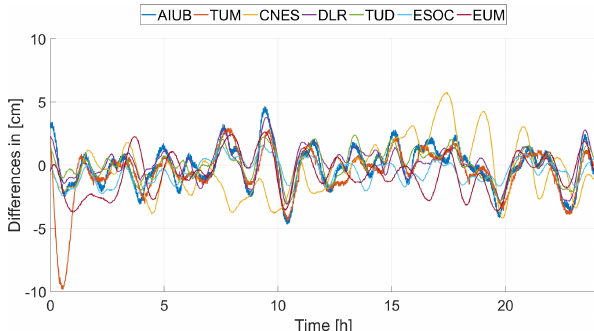
Figure 1. Along-track differences between individual solutions and CPOD solution for 24 September 2017, no Helmert transformation